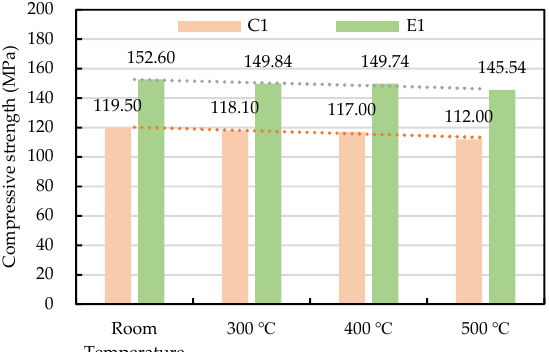
Figure 6. The trend of the residual compressive strength of the concrete after being subjected to high temperatures.